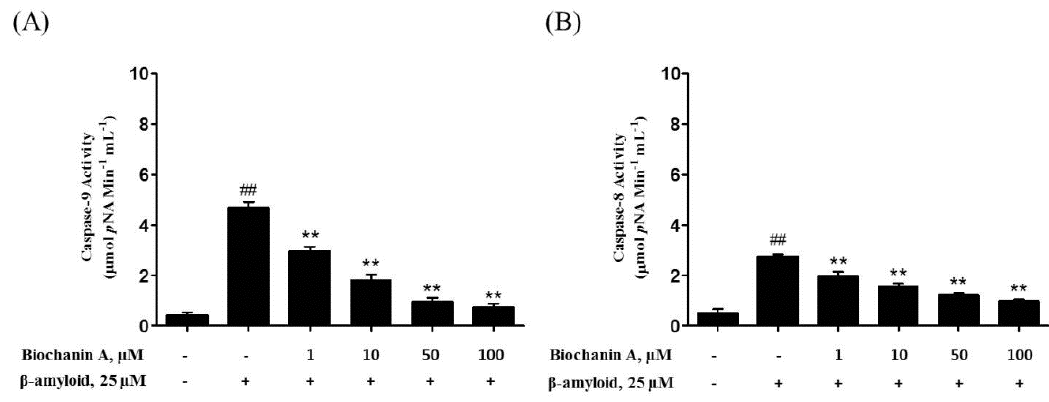
Figure 4. Cont Figure 4. Cont . Figure 4. Cont .